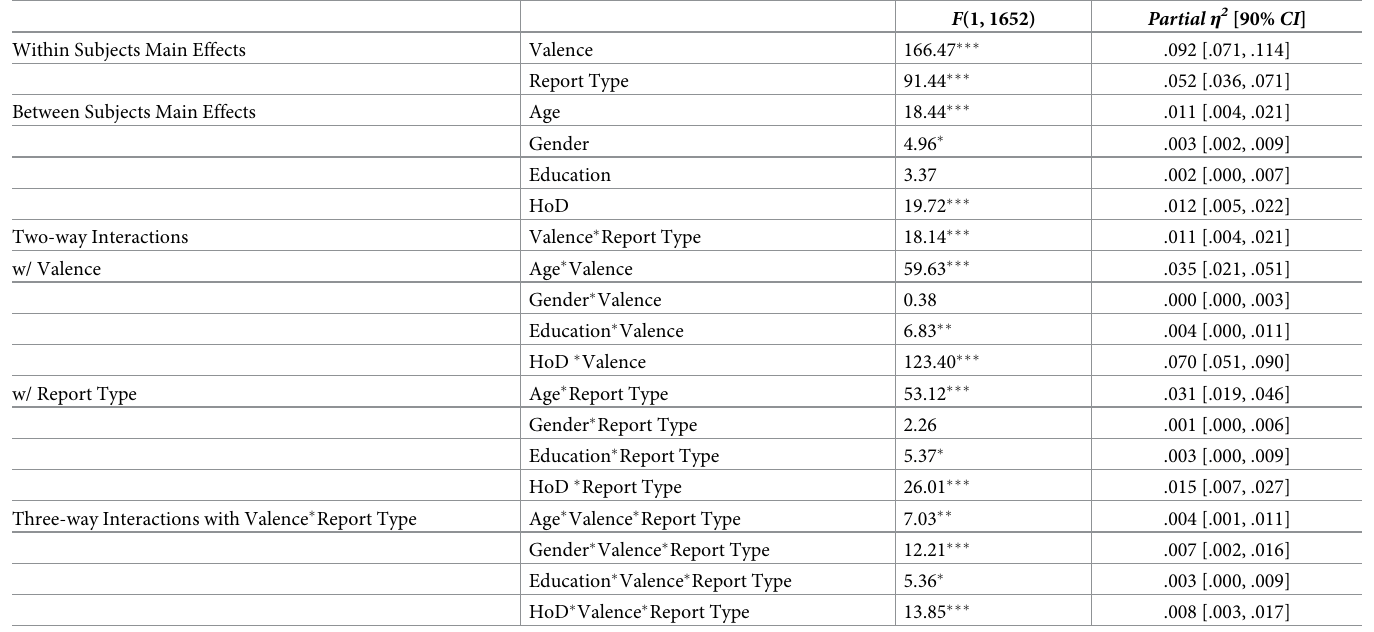
Table 2. Effects of history of depression on experience and recall of positive & negative